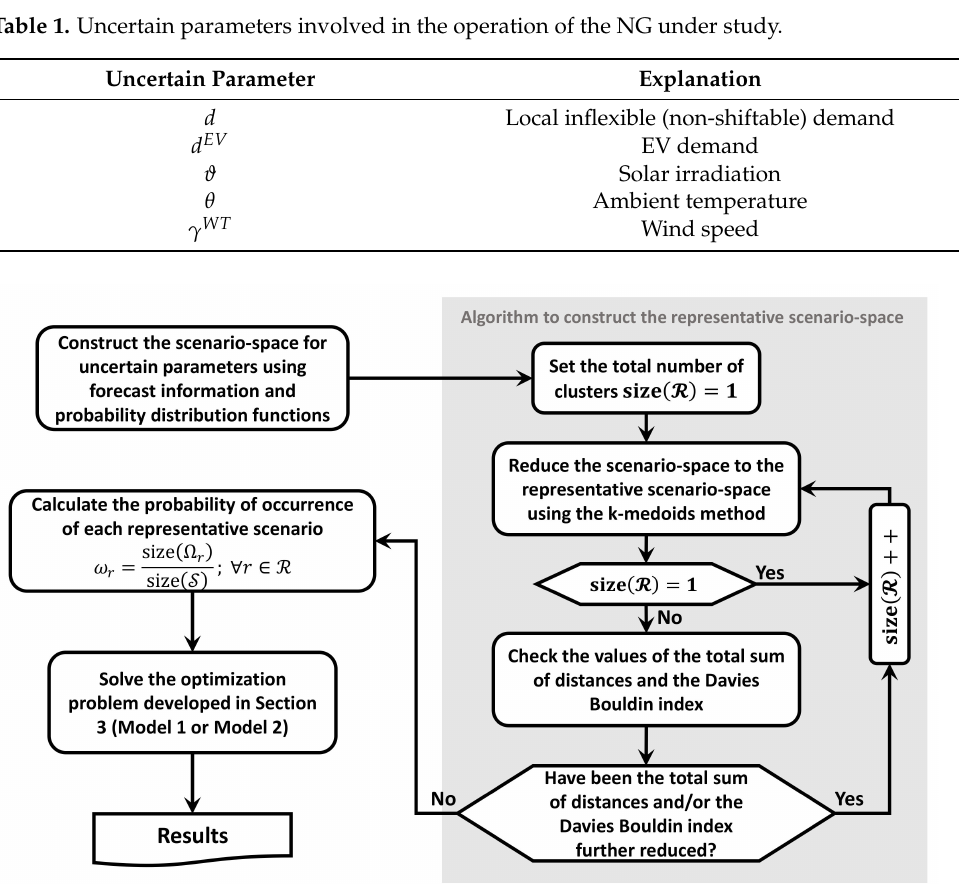
Figure 4. Proposed flowchart for solving the proposed optimal scheduling problem with stochastic modeling of